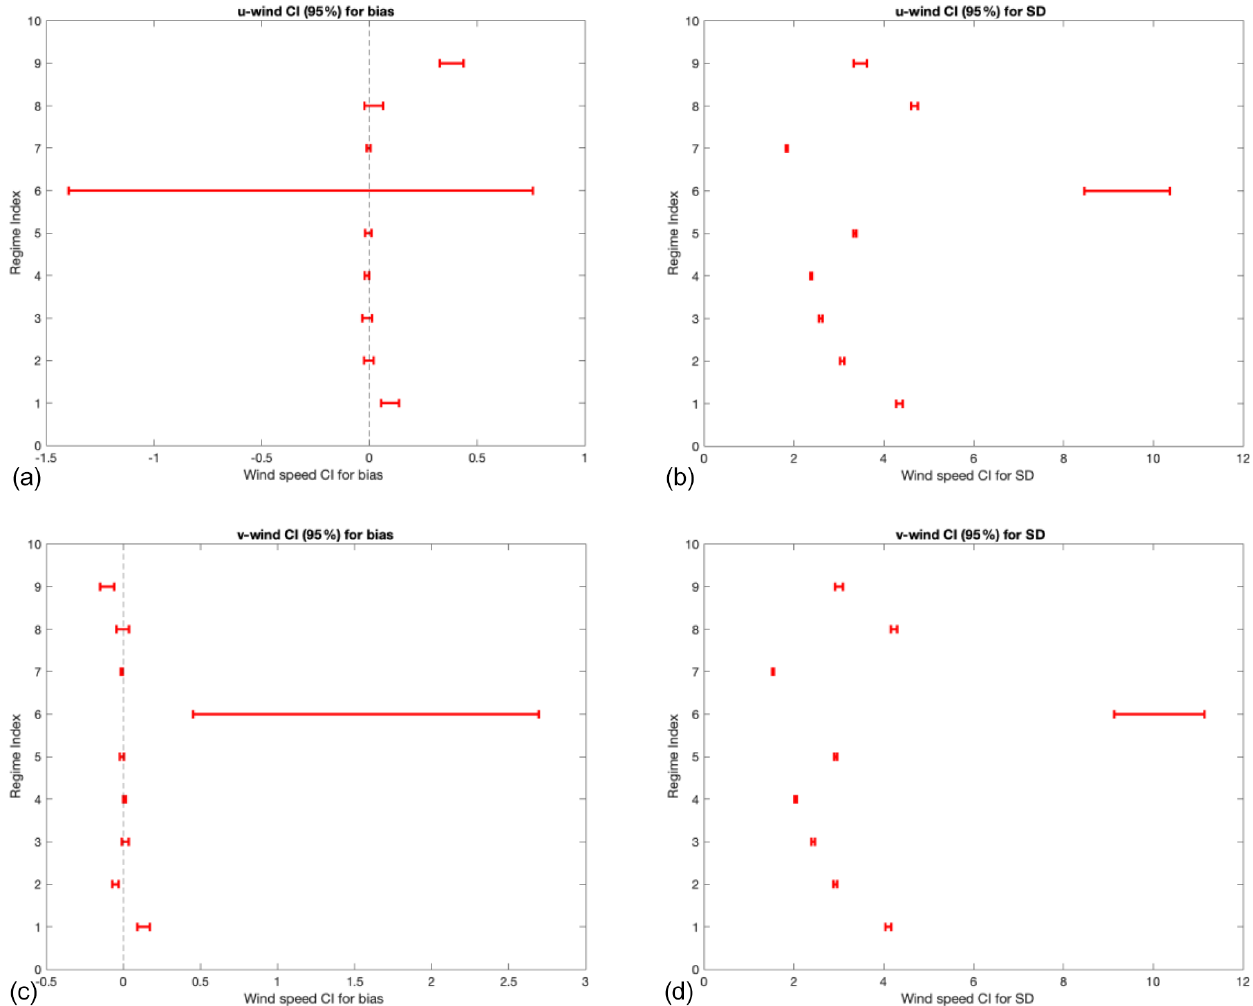
Figure 18. (a, b) Bias and SD confidence intervals for u wind; (c, d) bias and SD confidence intervals for v winds. The interval represents a 95% confidence